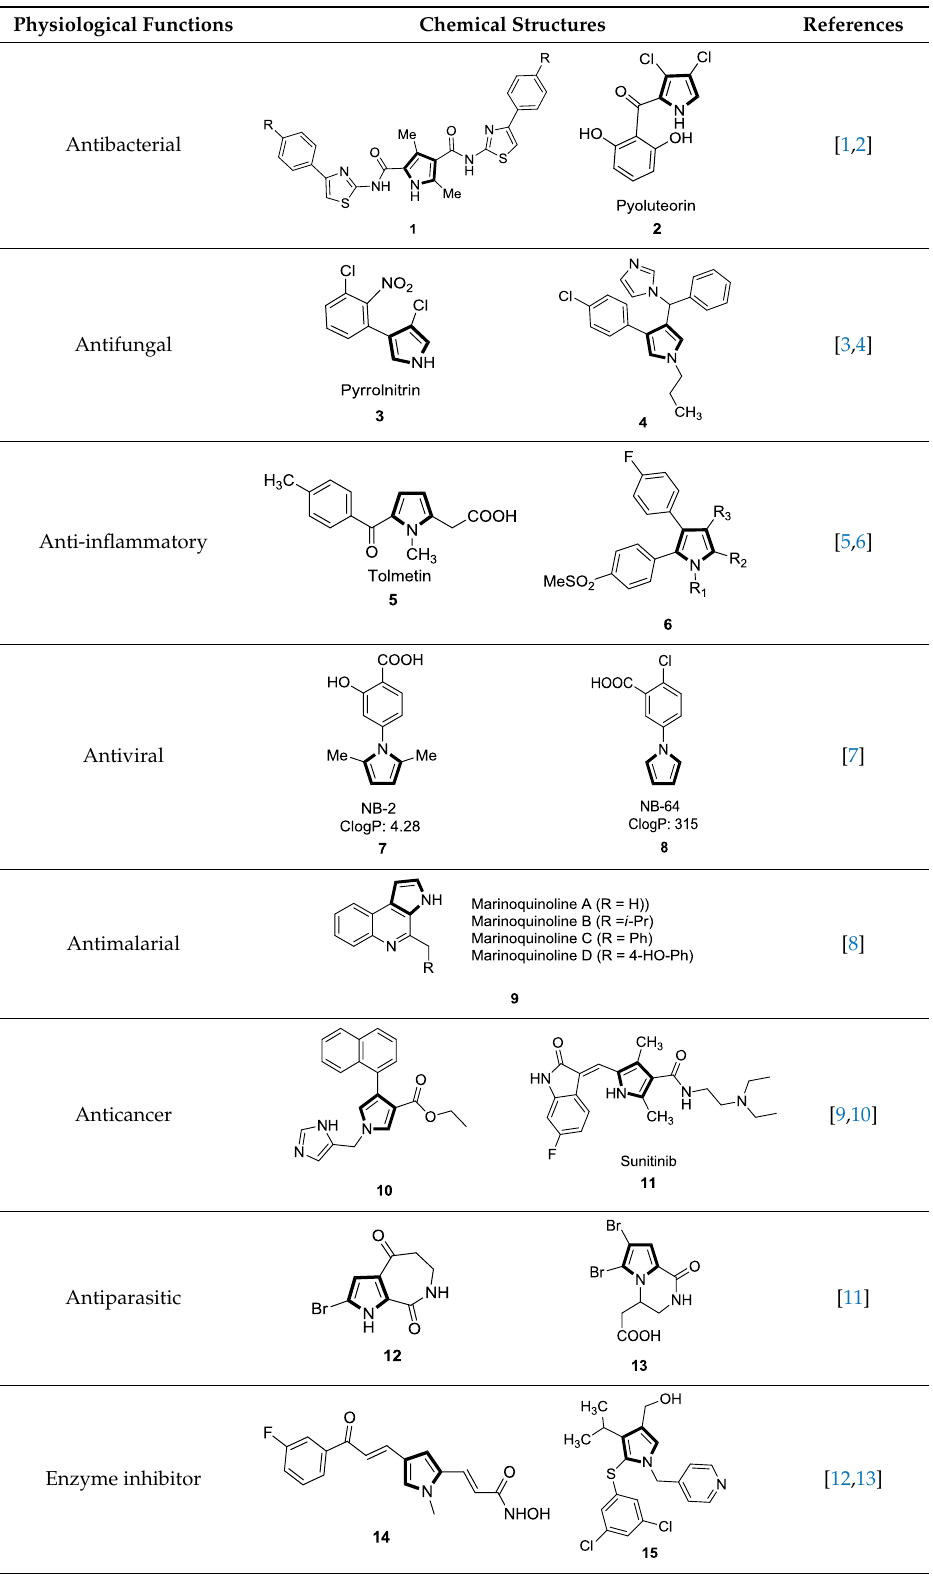
Table 1. Some typical pyrrole derivative chemical structures and the physiological functions.